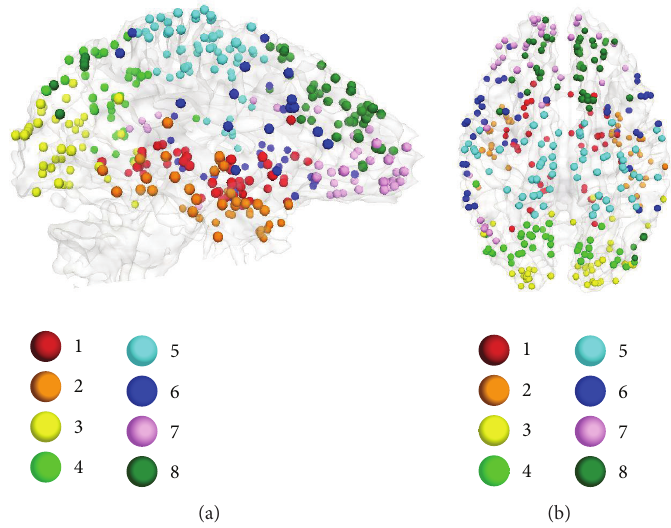
Figure 6: Eight functional connectivity clusters as results of using a multiview group-wise clustering. Eight functional clusters were identified in different colored